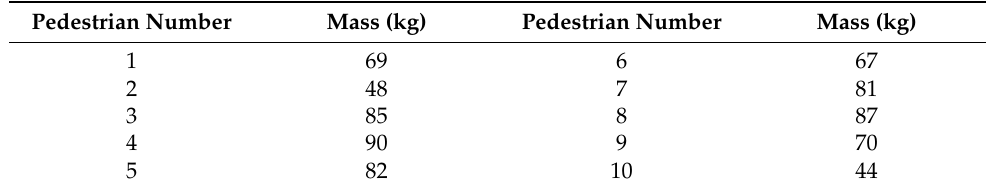
Figure 4. Pedestrian tests: ( a ) instrumented leading pedestrian; ( b ) single crossing; ( c ) group crossing; ( d ) pedestrian arrangement. Table 1. Mass of the test subjects.